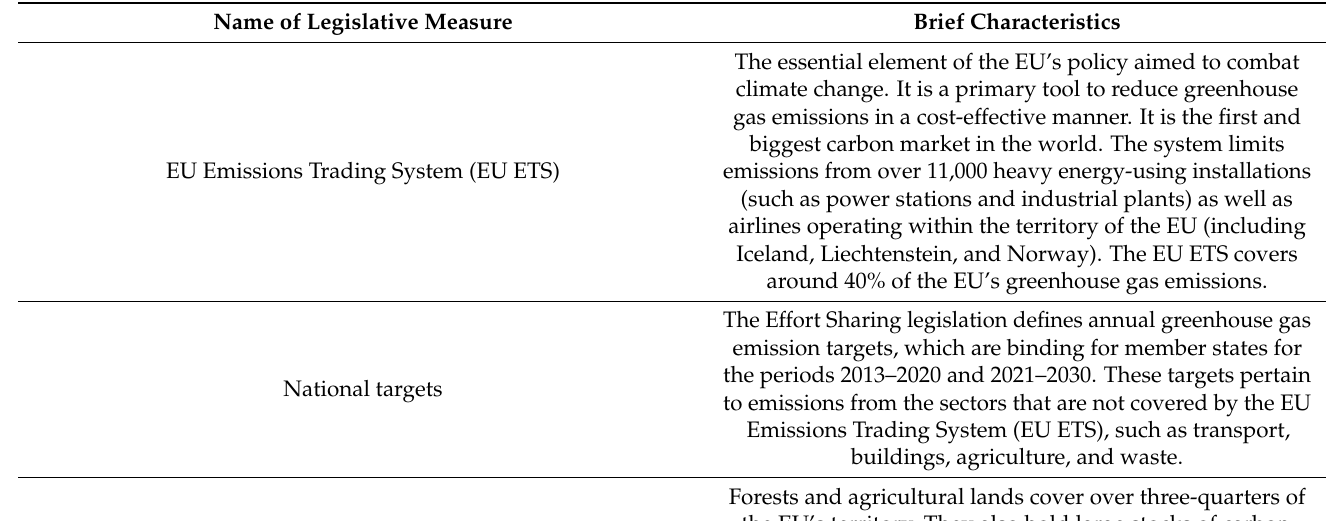
Table 1. Essential EU measures aimed at promoting